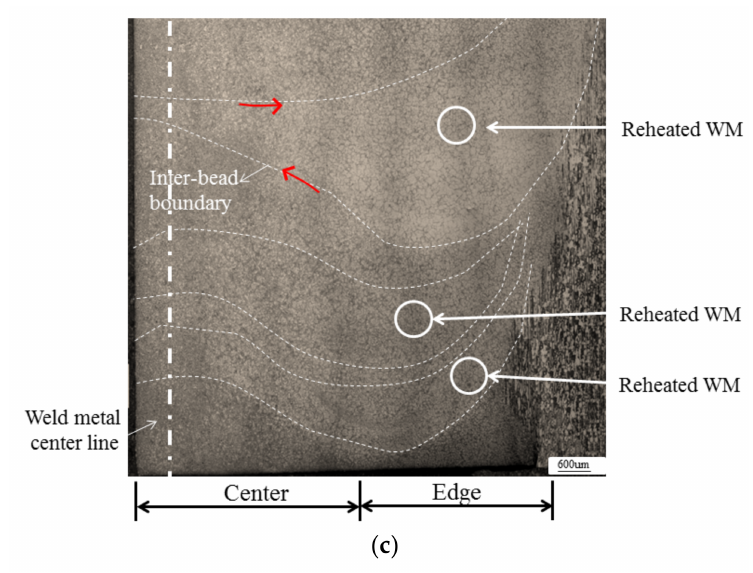
Figure 4. Region map on the macro of top view from location ‘A’, ’B’, ’C’ from Figure 2a–c: ( a ) low heat input; ( b ) medium heat input; and ( c ) high heat input.